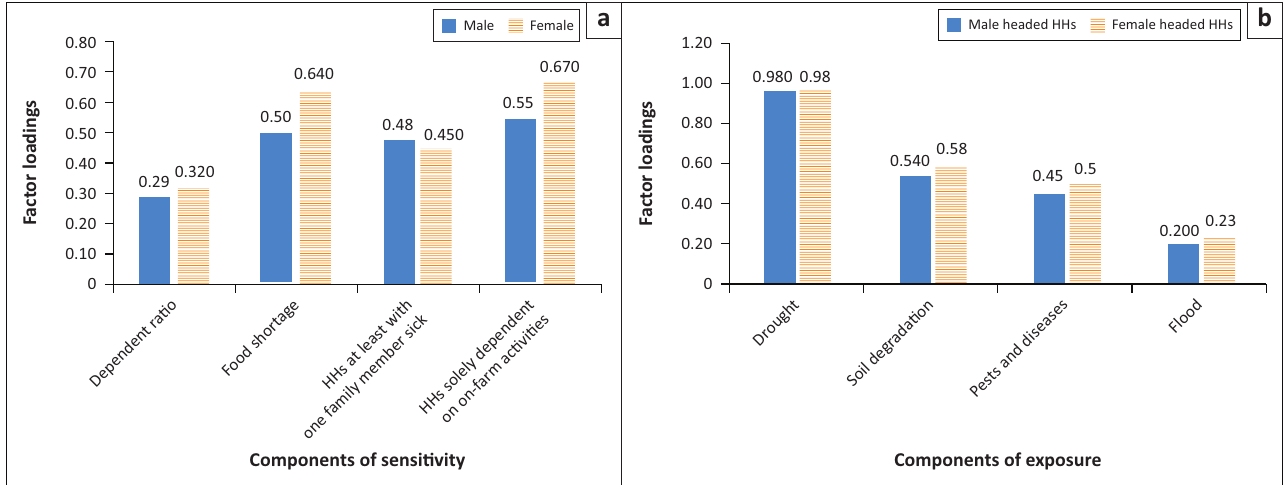
FIGURE 3: Factor loadings of indicators of sensitivity and exposure